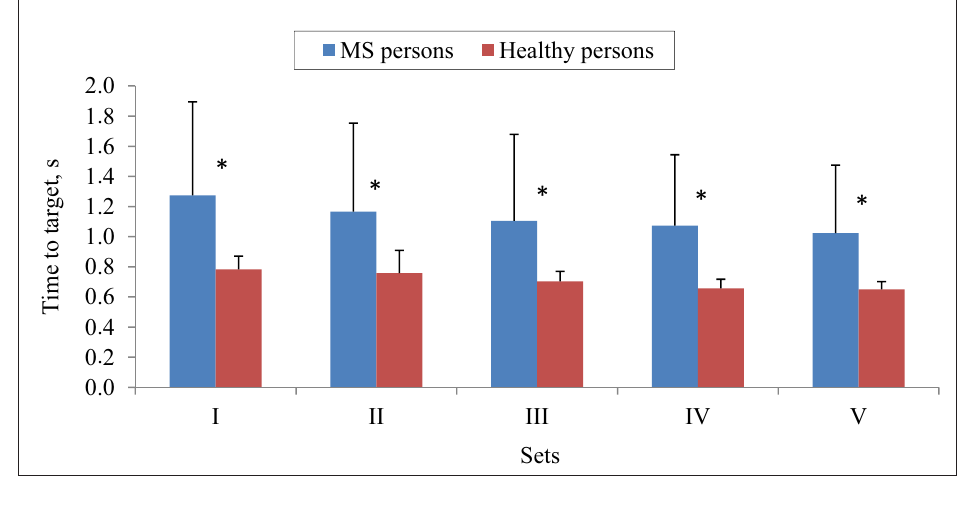
Figure 2. Mean values Figure 1. Mean values of time to target (s) for MS persons and healthy persons performing of average the task – five sets with 20 repetitions in each set